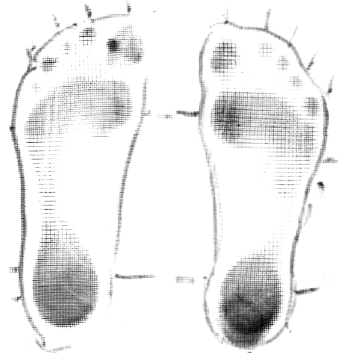
Figure 9. Participant 7 left and right final pedograph footprint (2017).